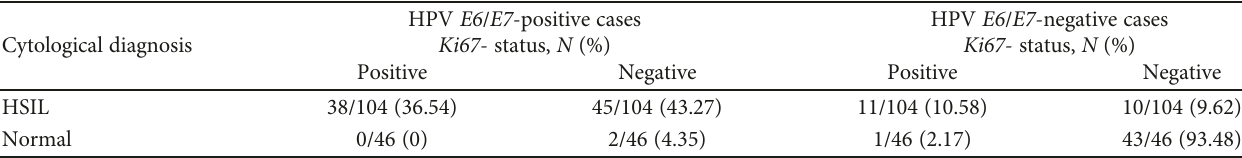
Table 4: RT-qPCR analysis of HPV E6/E7 and Ki67 mRNA expression in HSIL versus normal clinical specimens. Cytological diagnosis